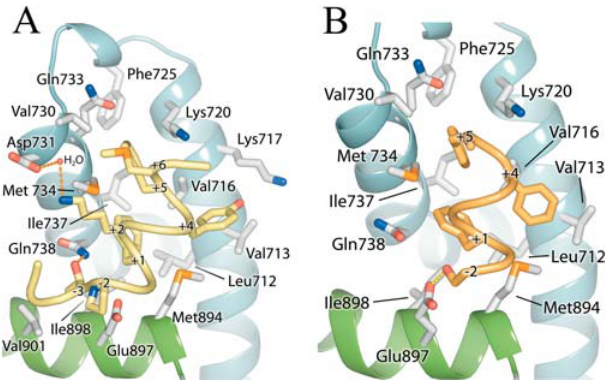
Figure 7. Interactions of FxxYF and FxxFF with the AR LBD FxxYF (A) and FxxFF (B) bound to the AR AF-2 interface. FxxYF and FxxFF are shown as yellow and orange C a coils, respectively. The